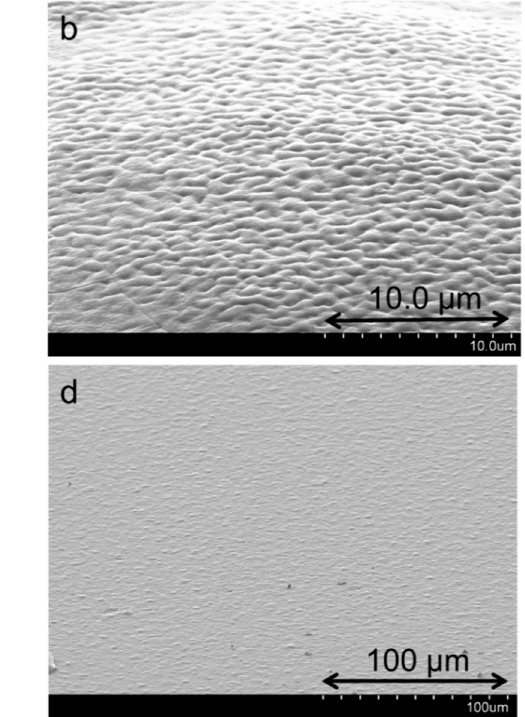
Figure 8. Thermogravimetric analysis of 100 layers of (1) PDDA-[Laponite + PAA, 4:1] multilayers, (2) PDDA-[Laponite + PAA, 3:2] multilayers, (3) PDDA-[Laponite + PAA, 2:3] multilayers, and (4) PDDA-[Laponite + PAA, 1:4] multilayers.